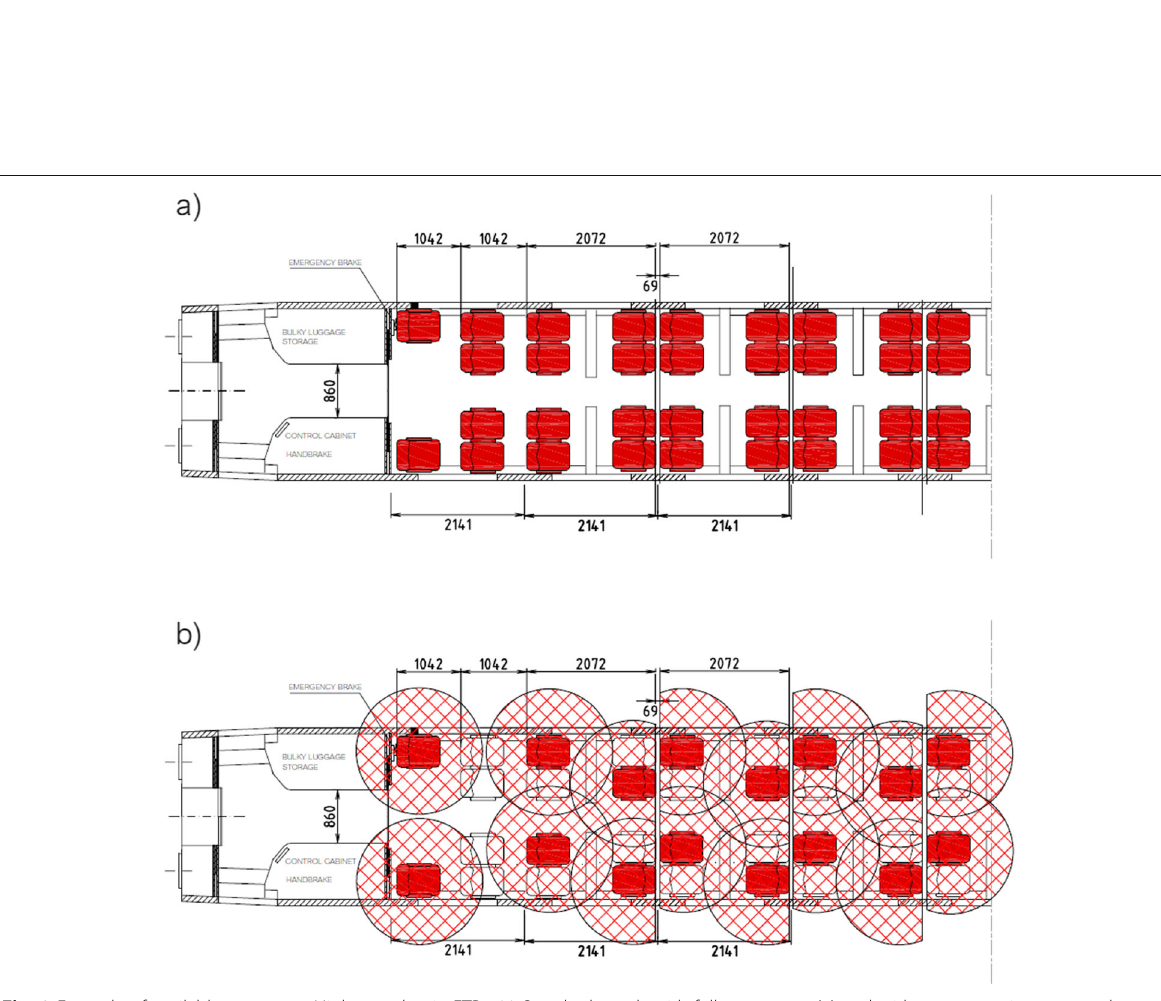
Fig. 2 Example of available seats on a High-speed train ETR 500 Standard coach with full occupancy ( a ) and with one-meter interpersonal distancing ( b ): in red the seats available; measurements in